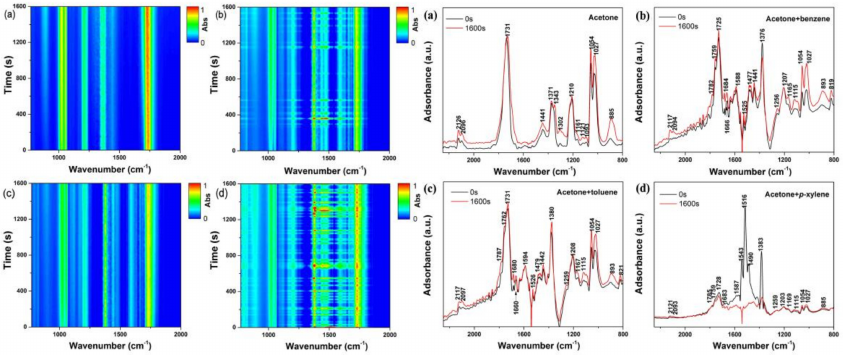
Figure 7. In situ FTIR results of the VOC degradation process at energy density (ED) = 1600 J/L: acetone ( a ); acetone–benzene ( b ); acetone–toluene ( c ); acetone– p -xylene ( d